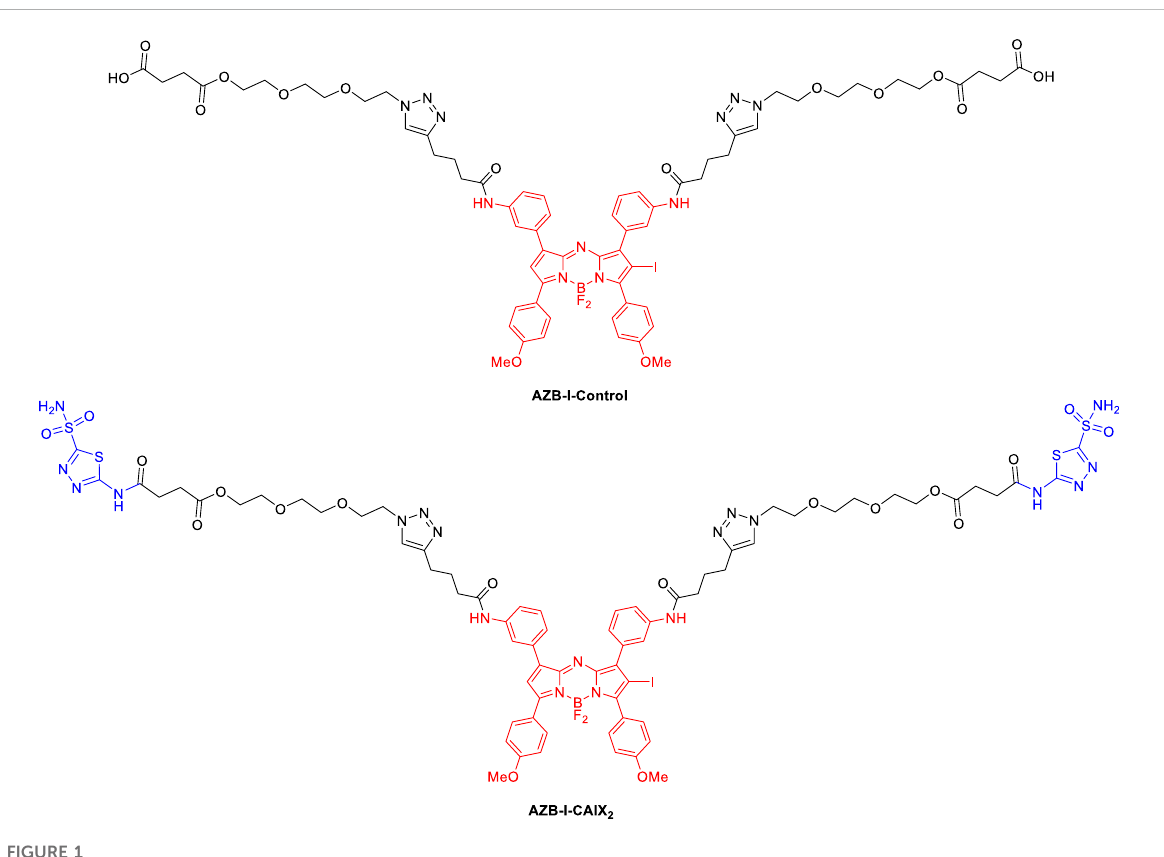
Structures of targeting probe (AZB-I-CAIX 2 ) and control (AZB-I-control) in this